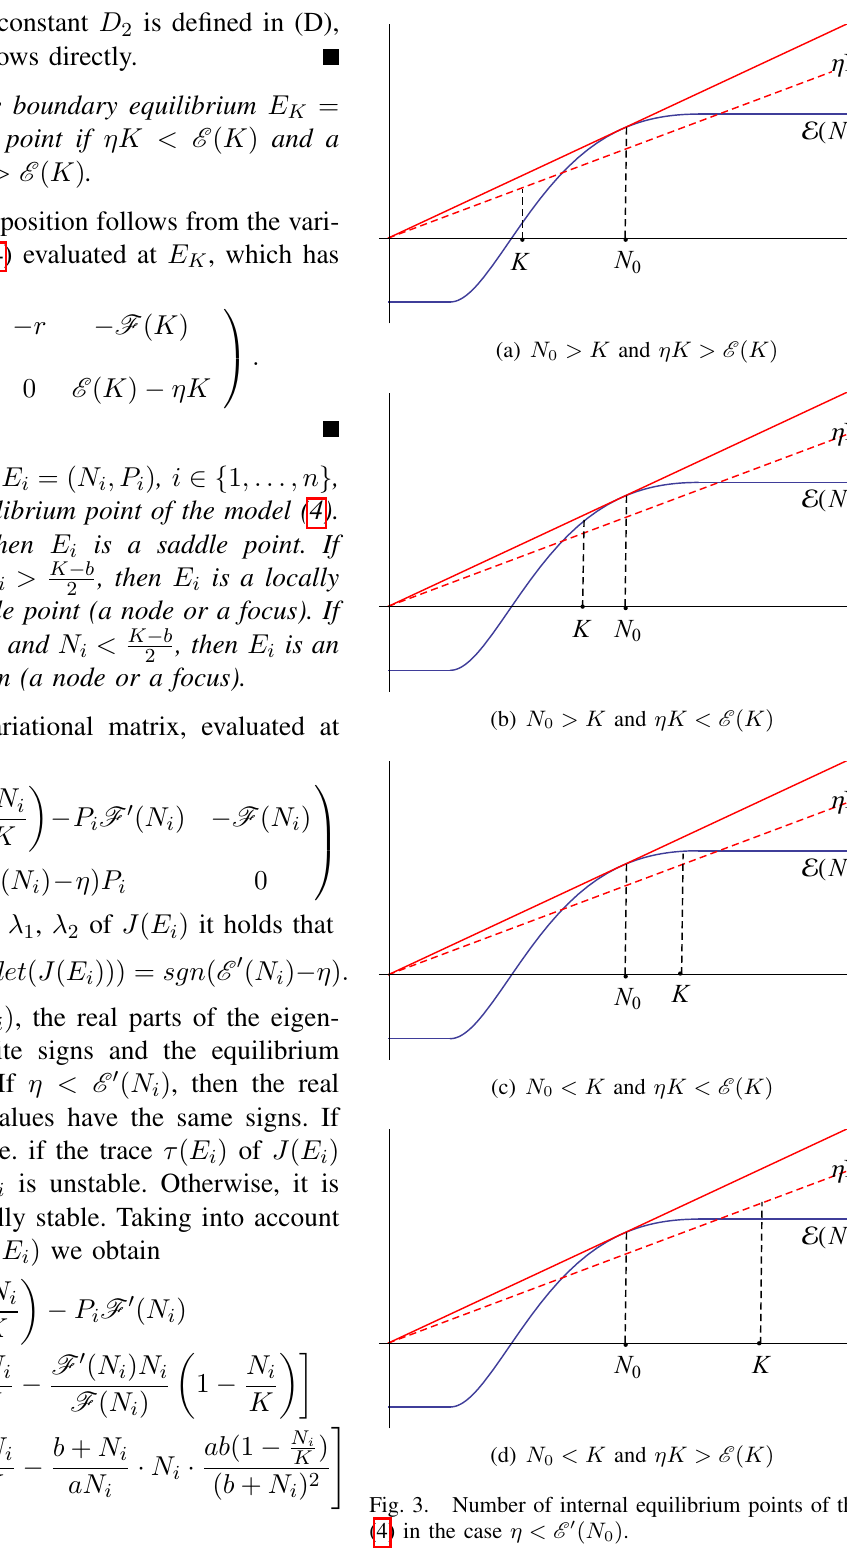
Fig. 3. Number of internal equilibrium points of the model (4) in the case η < E (cid:48) ( N 0 )